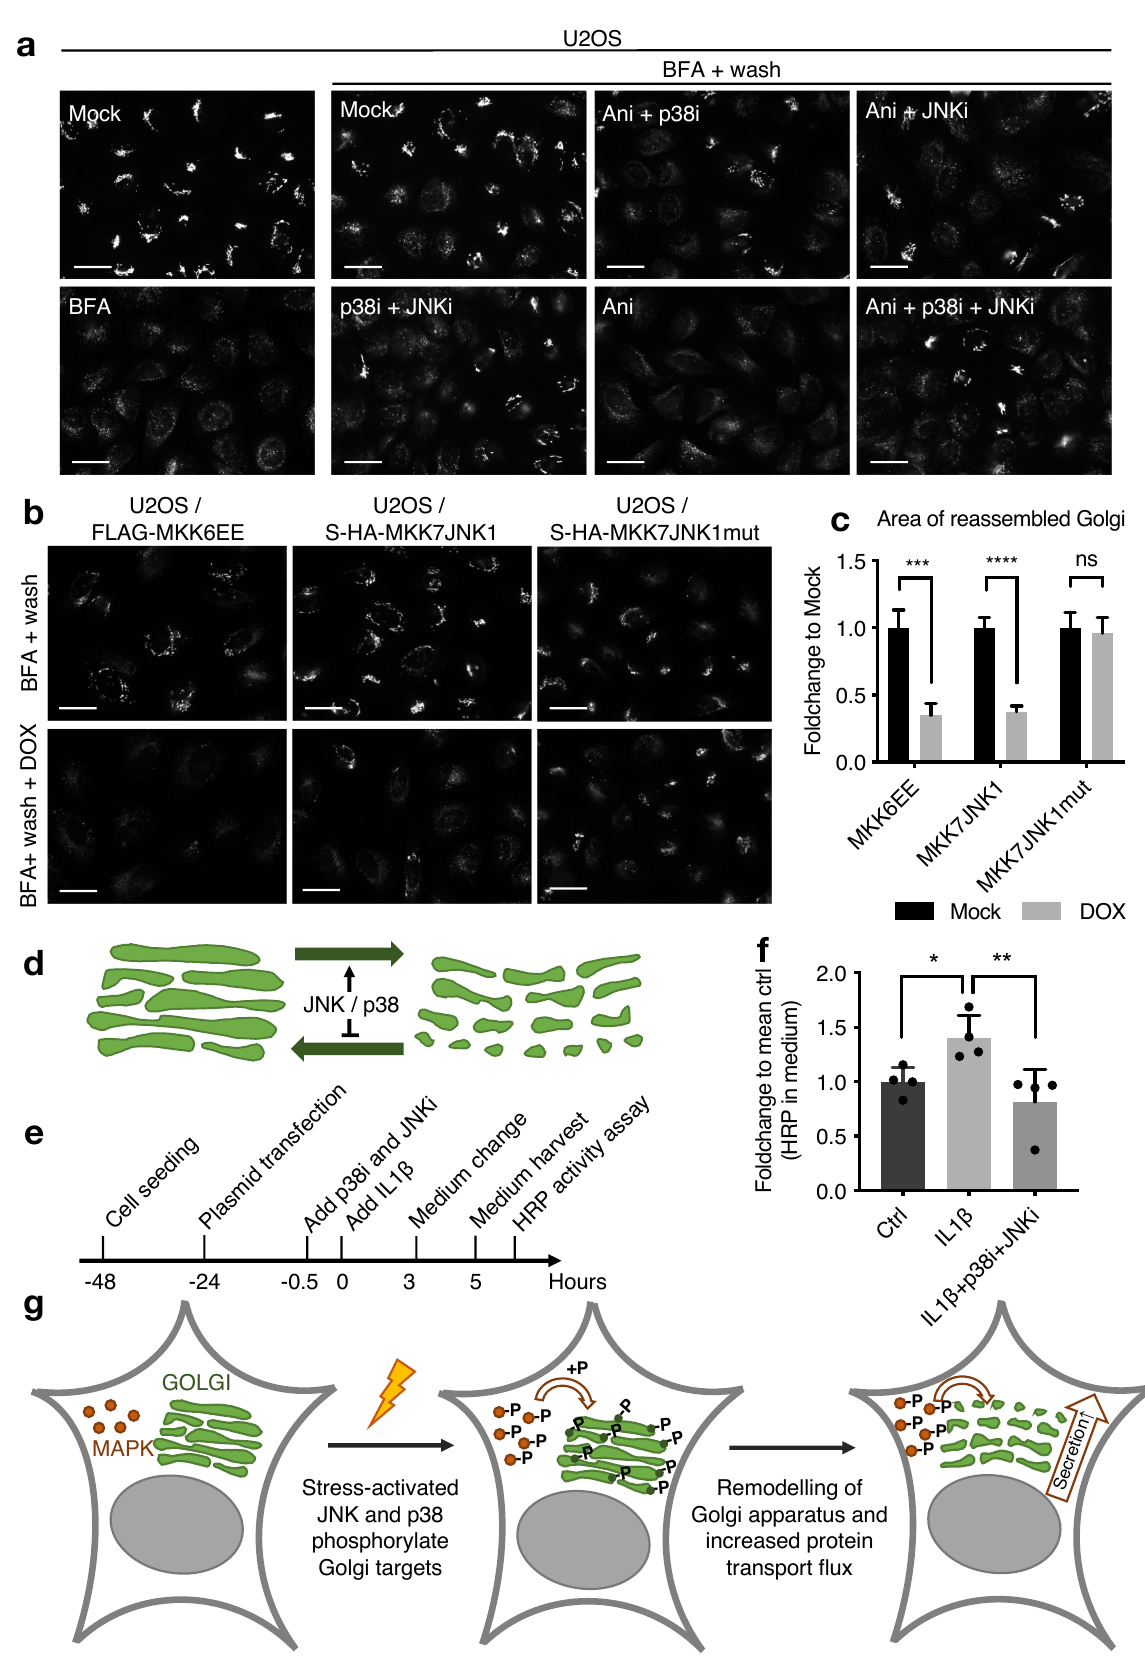
Figure 6. Regulation of Golgi dynamics and protein flux by p38 and JNK. ( a ). To dismantle the Golgi apparatus, U2OS cells were treated with Brefeldin A (BFA–1 h). This was done in the presence of p38 inhibitor, JNK inhibitor (p38i, JNKi, both